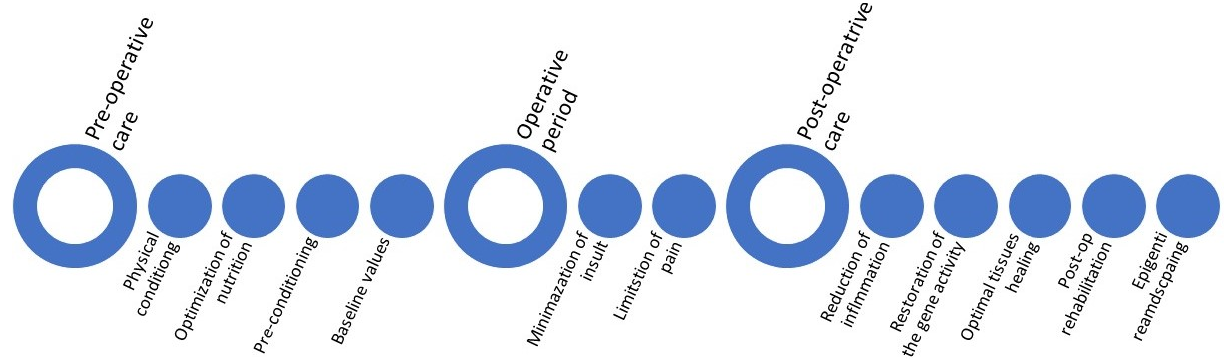
Figure 3. Strategies to improve peri-operative and long-term outcomes